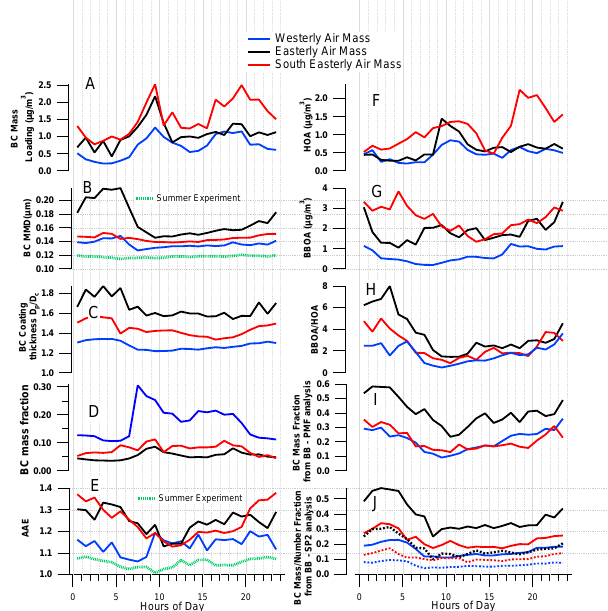
Figure 9. The diurnal trends of BC-related parameters classified by air mass. The lines show the median values of the data set. (a) rBC mass loading; (b) BC core MMD, with the dotted green line show- ing the summer result; (c) BC coating thickness D p /D c ; (d) BC mass fraction; (e) the absorption Ångström exponent with dotted green line showing the summer result; (f) HOA mass loading from AMS-PMF; (g) SFOA total (SFOA I + SFOA II) mass loading from AMS-PMF; (h) SFOA total /HOA ratio; (i) BC mass fraction from solid fuel burning attributed by BC–AMS–PMF method (Sect. 3.3); and (j) BC mass/number fraction from solid fuel burning attributed by SP2 method (Sect. 3.5), with the dotted lines showing the num- ber